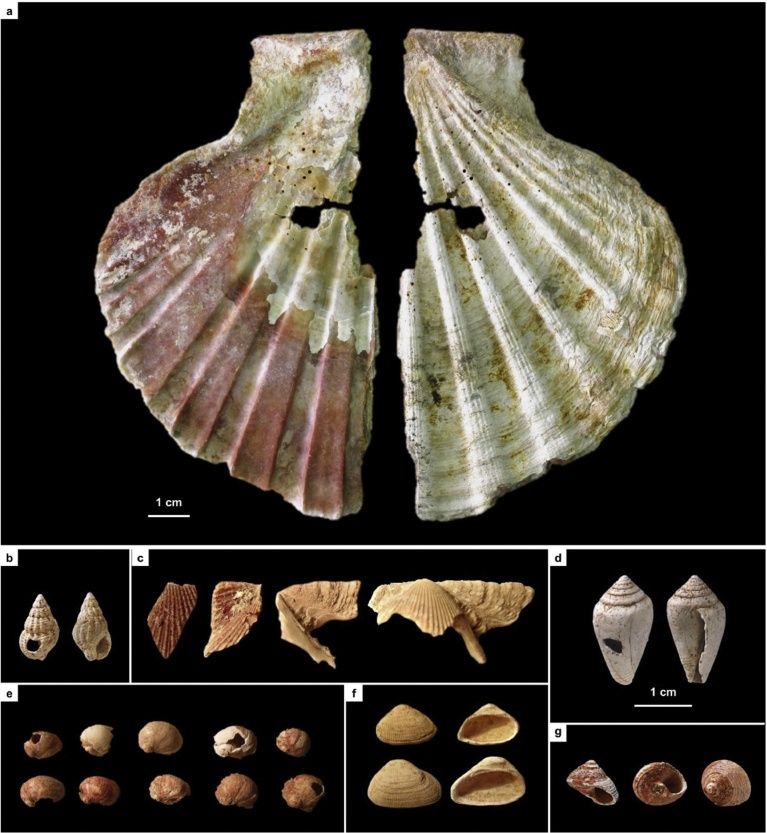
Ornamental shell across the Middle-to-Upper Paleolithic transition in the Mula basin sites. a. Pecten half-valve from Middle Palaeolithic layer I-k of Cueva Antón (after Zilhão et al., 2010a); the reddish color of the internal side is natural; remnants of an orange colorant made of goethite and hematite are visible in the side that was painted (the external, whitish one). b–g. perforated and/or ochre-stained bivalve and gastropod shell (all at the same scale) from the Aurignacian of La Boja (for additional detail and taxonomic identifications, see the SI appendix).